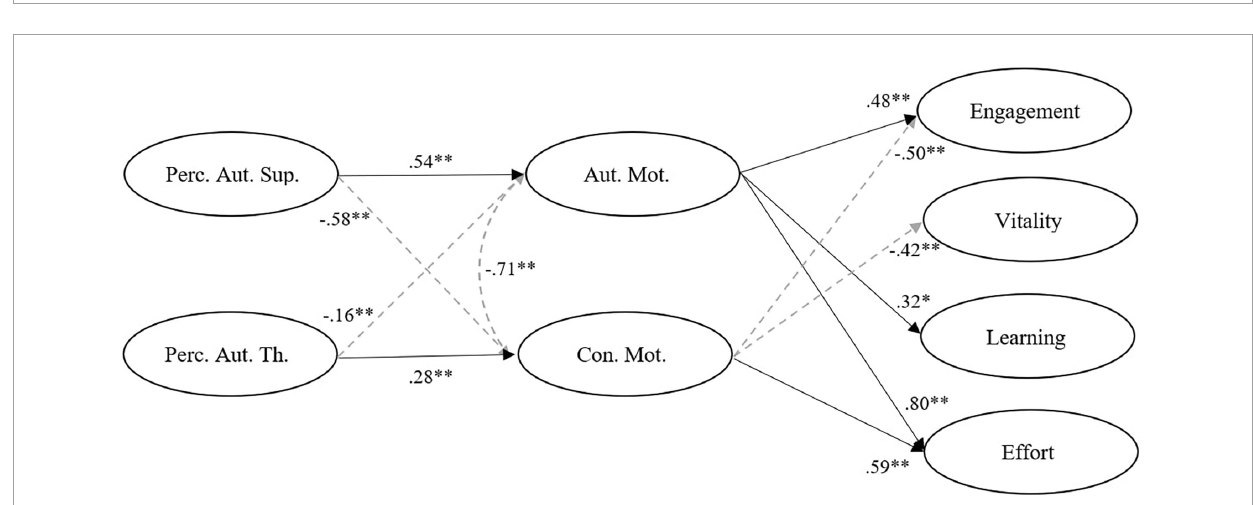
FIGURE2 Modified path diagram with standardized regression coefficients. Solid lines indicate positive relationships, dotted lines indicate negative relationships. ∗ p < 0.05, ∗∗ p < 0.01. Perc. Aut. Sup., perceived autonomy support; Perc. Aut. Th., perceived autonomy thwarting; Aut. Mot., autonomous motivation; Con. Mot., controlled motivation. For clarity, non-significant paths have been removed from the